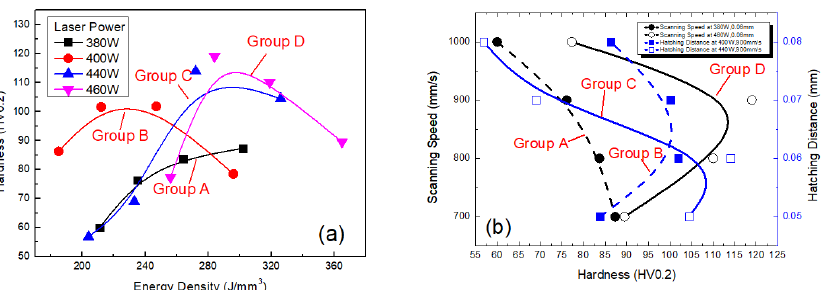
Figure 7. Hardness of the SLM alloy under different process parameters: ( a ) hardness of the alloy versus energy density (laser power is labeled according to different groups via different symbols and legends) and ( b ) scanning speed and hatching distances versus hardness of the alloy.